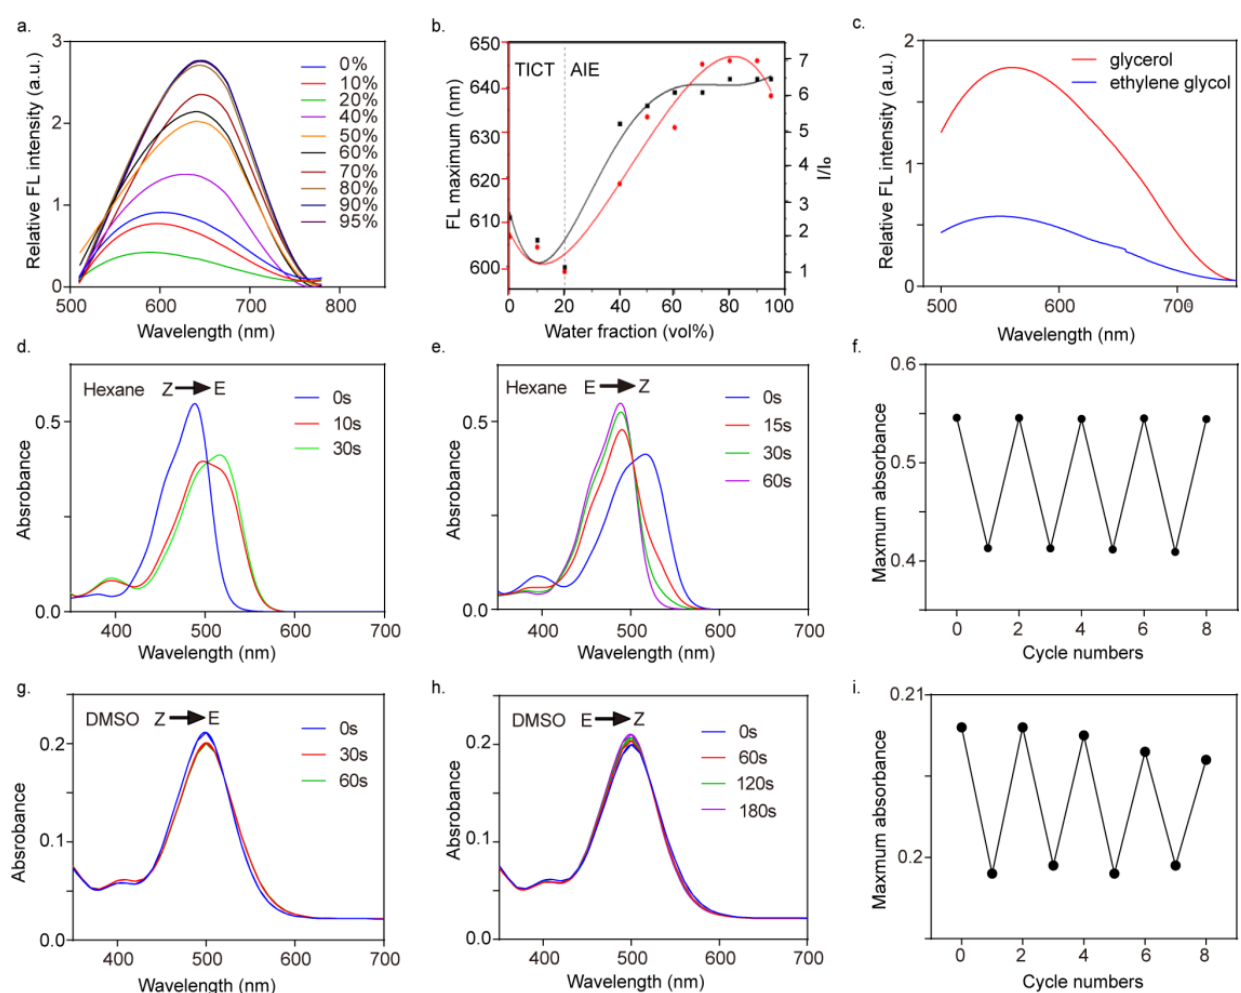
Figure 1. AIE properties and photochromism of 6Br-HTI-TPA-OMe in organic solutions. ( a ) The fluorescence spectra of 6Br-HTI-TPA-OMe in DMSO/H 2 O mixtures with different water fractions ( v/v ) (50 µ M, λ ex = 495 nm); ( b ) plot of maximum fluorescence (red) and relative fluorescence intensity (I/I 0 , black) versus the composition of the DMSO/H 2 O mixtures, where I 0 was the fluorescence intensity at 20% f w ; ( c ) the fluorescence spectra of 6Br-HTI-TPA-OMe in glycerol and ethylene glycol (10 µ M, λ ex = 450 nm); the absorption spectra changes ( d , e ) and fatigue resistance ( f ) of 6Br-HTI-TPA-OMe in hexane (10 µ M) upon switching LED light either with 480 nm or 580 nm; the absorption spectra changes ( g , h ) and fatigue resistance ( i ) of 6Br-HTI-TPA-OMe in DMSO (10 µ M) upon alternating irradiation light either with 480 nm or 580 nm.